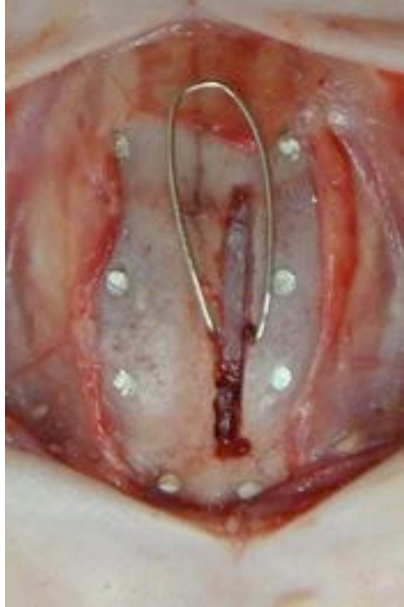
FIGURE 3 - Group IV with placement of amalgam markers, parasagittal linear craniectomy and implantation of spring between M2 and